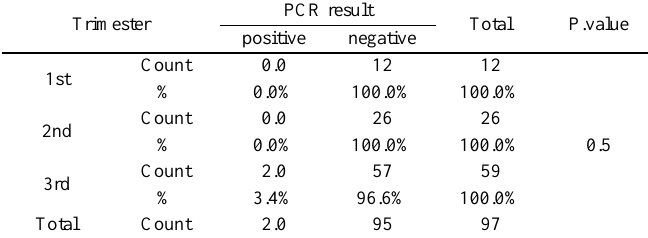
Table 3 : Correlation between PCR results and trimester Trimester